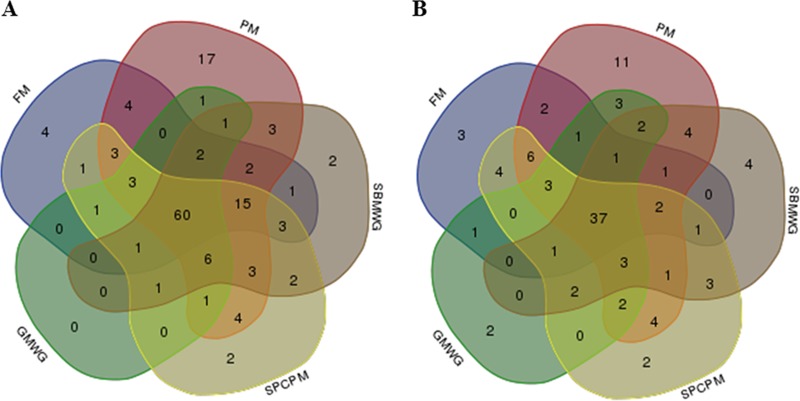
Venn diagrams showing compartmental OTU distributions of the core microbiota identified in the distal intestine of Atlantic salmon fed various diets. (A) OTU distribution in the digesta samples. Sixty OTU were identified as core microbiota (80% of samples) for all diets in the digesta. (B) OTU distribution in the mucosal samples. Thirty-seven OTU were identified as core microbiota (80% of samples) for all diets in the mucosa. Abbreviations are as defined for Fig. 1.